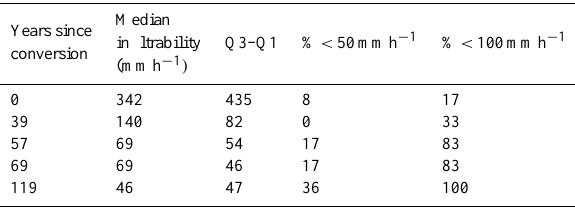
Table 2. Steady-state infiltrability (mmh − 1 ) for sites of different times since conversion to agriculture, represented by the median rate and % of readings above and below particular rates. Q3–Q1 is the interquartile range covering 50% of the